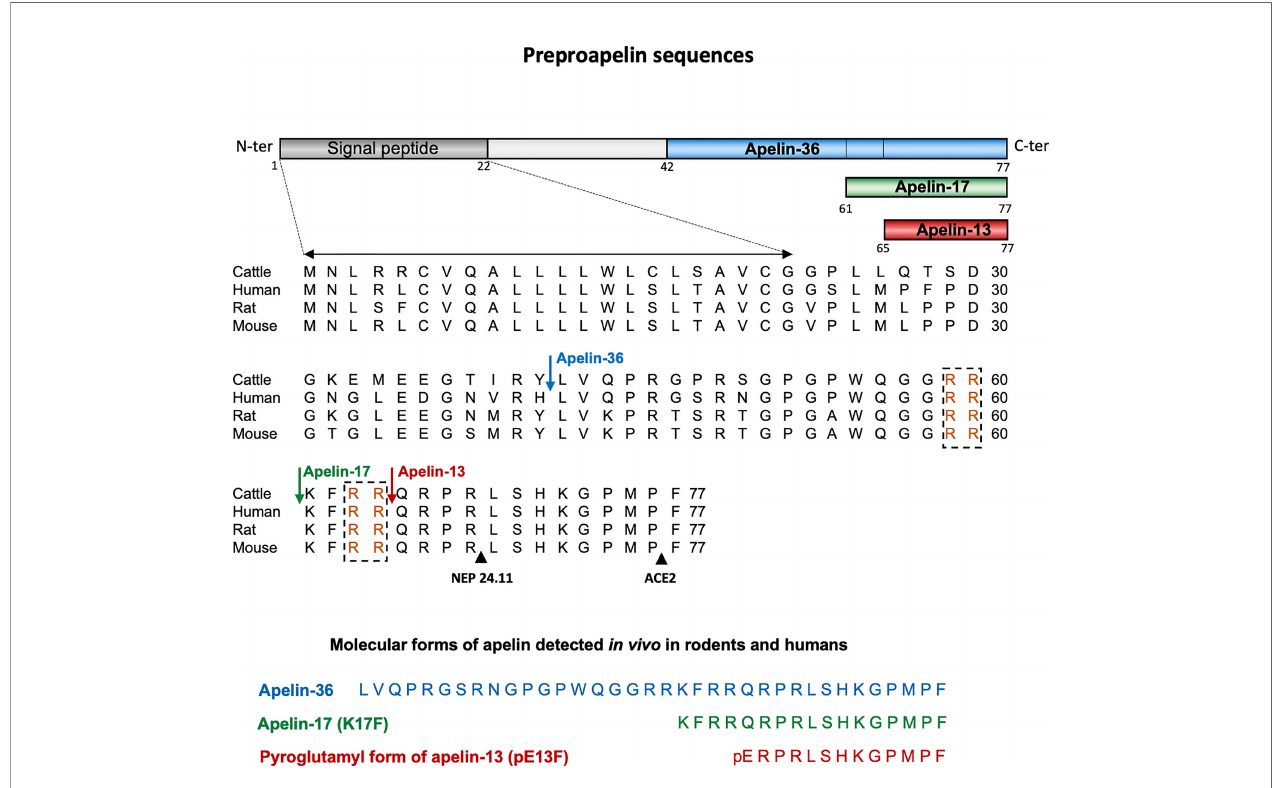
FIGURE 1 | Amino-acid sequences of the apelin precursor, preproapelin, in cattle, humans, rats, and mice, and the molecular forms of apelin detected in vivo . The blue arrow indicates the beginning of the sequence of apelin-36, the green one that of the sequence of apelin-17 (K17F), which is strictly conserved in mammals and the red one that of the apelin-13 sequence. The dibasic doublets (in orange) are framed by black dashed boxes. The black arrows show the cleavage sites by neutral endopeptidase 24.11 (NEP 24.11, EC 3.4.24.11) and angiotensin-converting enzyme 2 (ACE-2, EC 3.4.17.23). The various molecular forms of apelin detected in vivo in mammals: apelin-36, apelin-17, and the pyroglutamyl form of apelin-13. Figure adapted from Ref. (7) with permission from the copyright